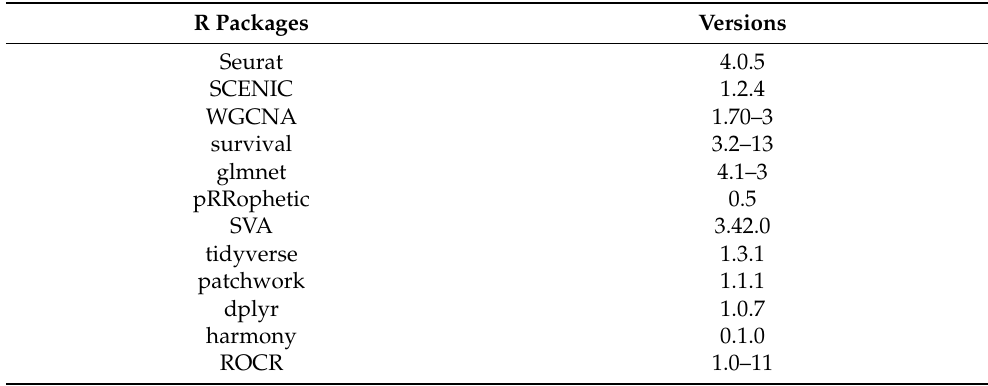
Table 1. Version-specific information for R packages. R